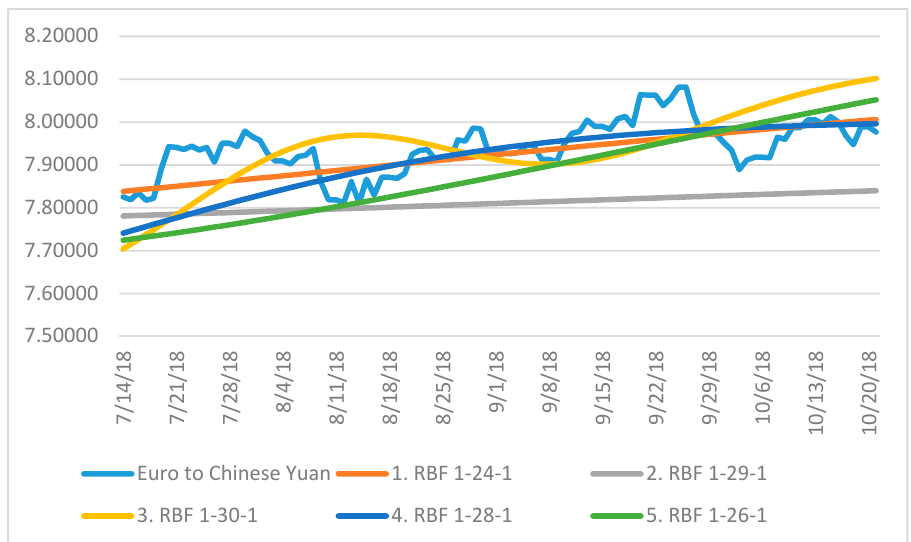
Figure 4. Line graph—development of the Euro to Yuan exchange rate predicted by neural networks in comparison with the actual exchange rate in the monitored period. (Source: Own processing.)